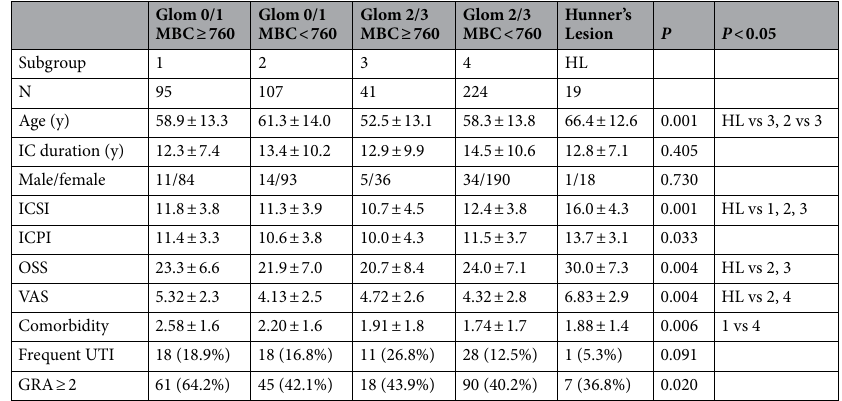
Table 3. Comparison of characteristics and interstitial cystitis symptom score parameters between the five subgroups of interstitial cystitis/bladder pain syndrome patients. The data are presented as mean ± standard deviation or number (percentage). Glom, glomerulation grade; MBC, maximal bladder capacity (ml); IC, interstitial cystitis; ICSI, Interstitial Cystitis Symptom Index; ICPI, Interstitial Cystitis Problem Index; OSS, O’Leary–Sant Symptom score; VAS, visual analog scale score for pain (0–10); GRA, Global Response Assessment score (GRA ≥ 2 indicates a satisfactory outcome); UTI, urinary tract infection.